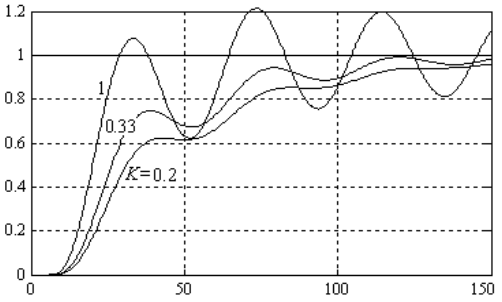
Figure 22. Responses y ( t ) to a unit step reference for K = 0.2; 0.33; 1.